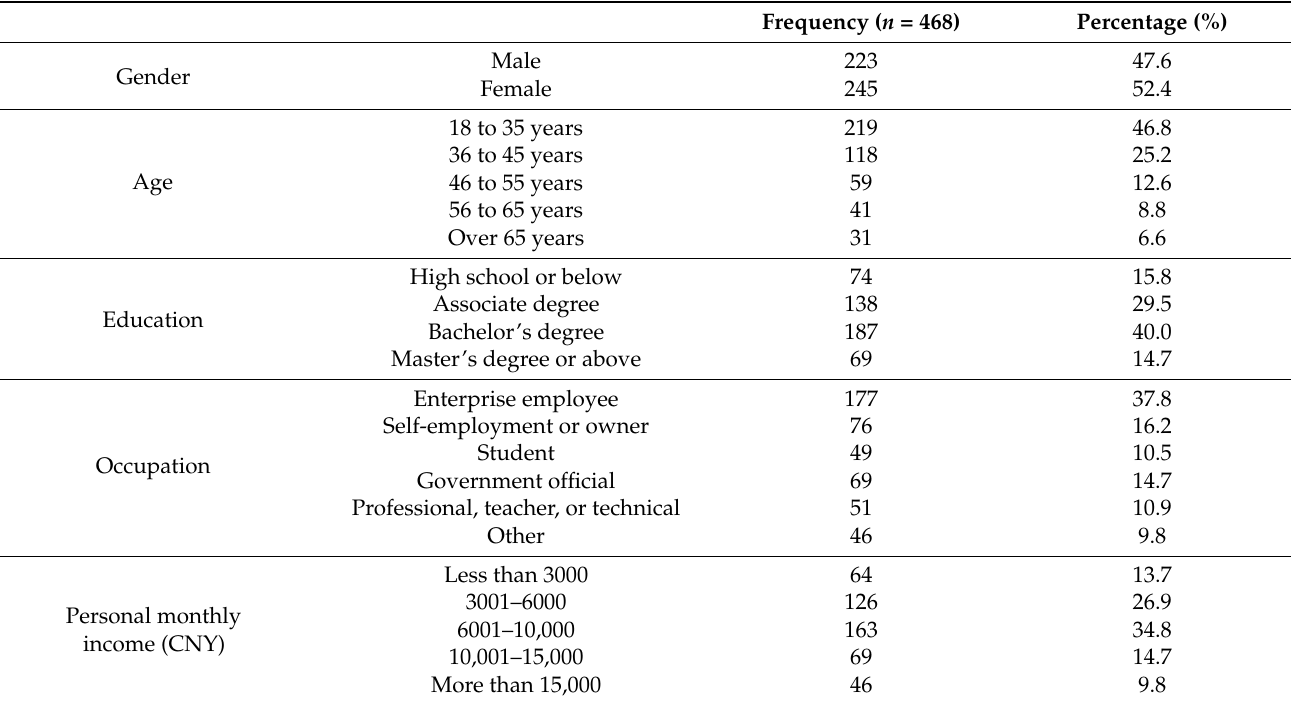
Table 1. Sociodemographic information of the study sample.